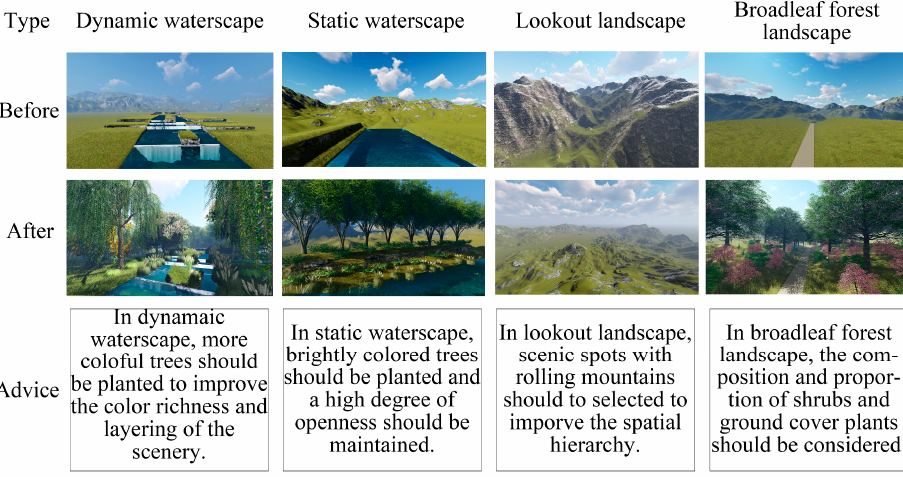
Figure 12. Suggestions on planning and design of forest landscapes. The graphics software is Lumion 6.0. This figure was created by the author.